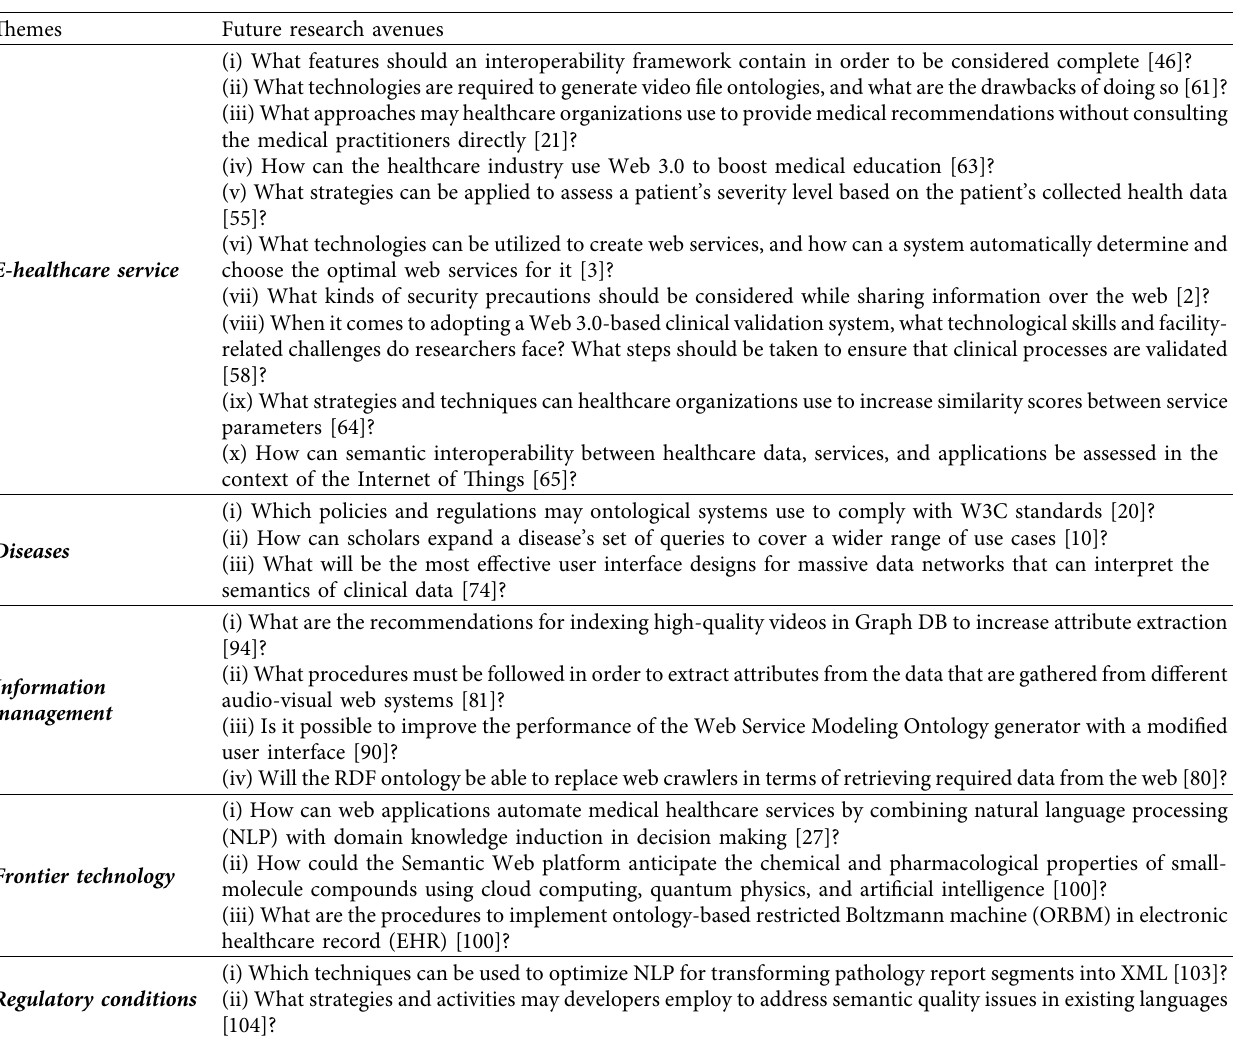
Table 5: Future research avenues in the form of research